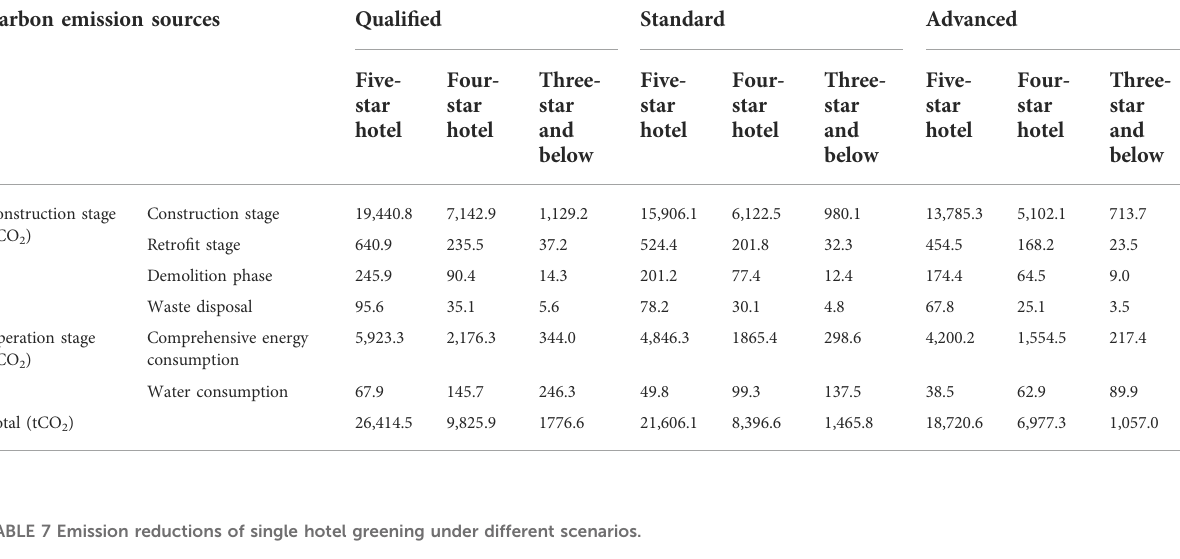
TABLE 6 Carbon emissions of a single star-rated green hotel under different scenarios.